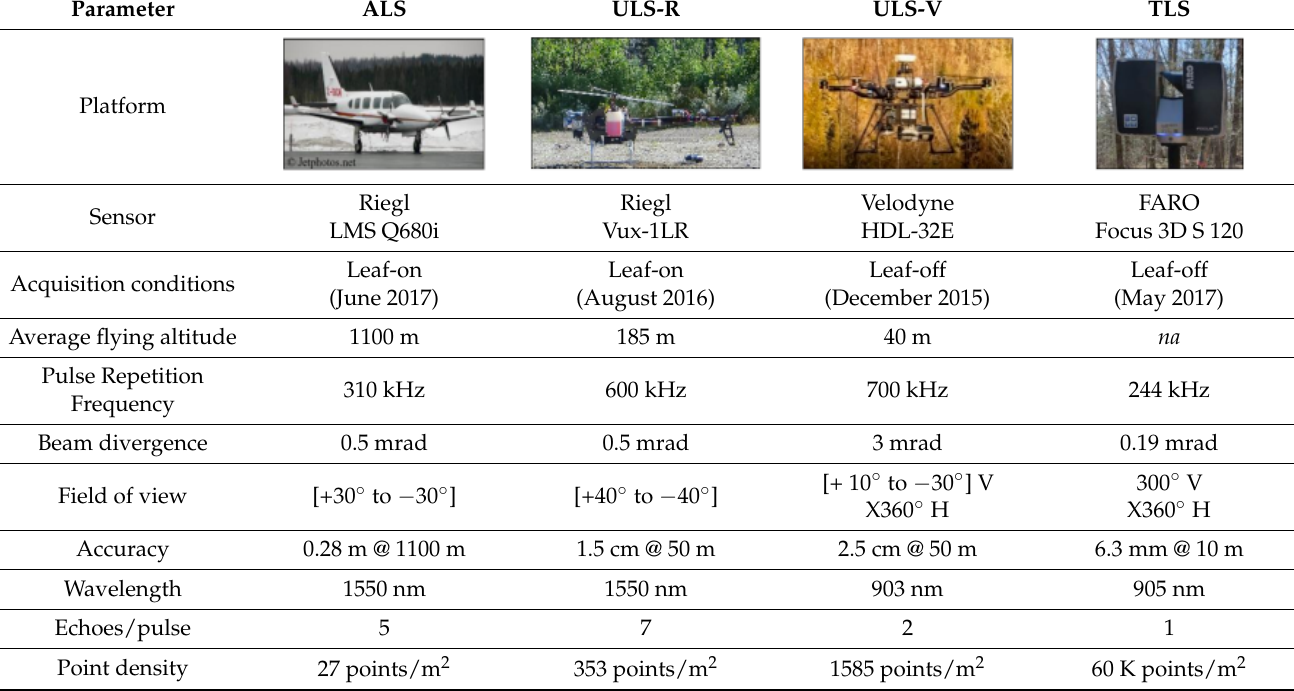
Table 1. Technical specifications of the deployed laser scanning systems, viz., Airborne Laser Scanning (ALS), UAV Laser Scanning (ULS) equipped with a Riegl Vux-1LR (ULS-R) sensor and a Velodyne HDL-32E (ULS-V) sensor, and Terrestrial Laser Scanning